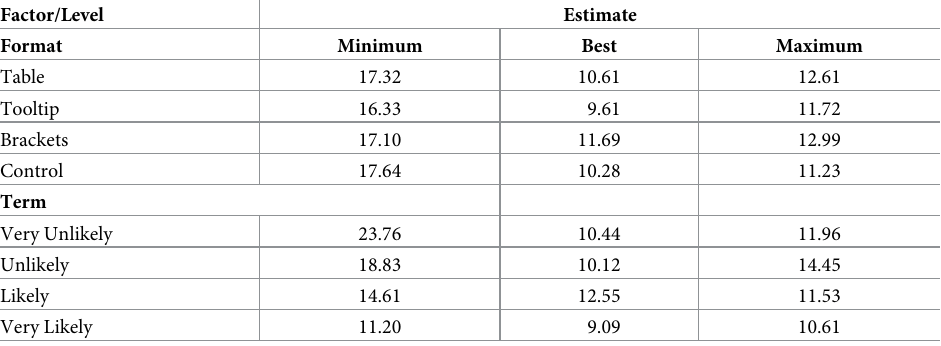
Table 2. Percentage of missing responses by estimate, probability term, and presentation